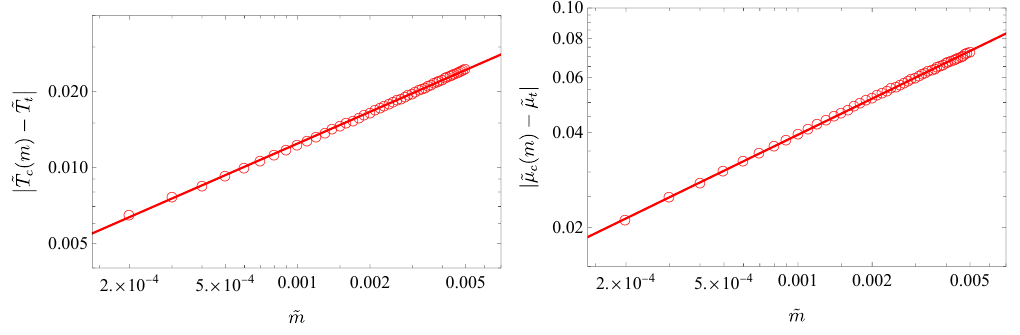
Figure 15 . The left and right panel shows | ˜ k | 2 − η ˜ G R respectively.